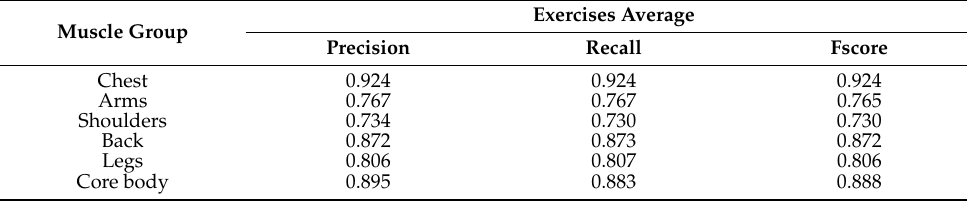
Table 5. Exercises average precision, recall, and F-score based on muscle group.